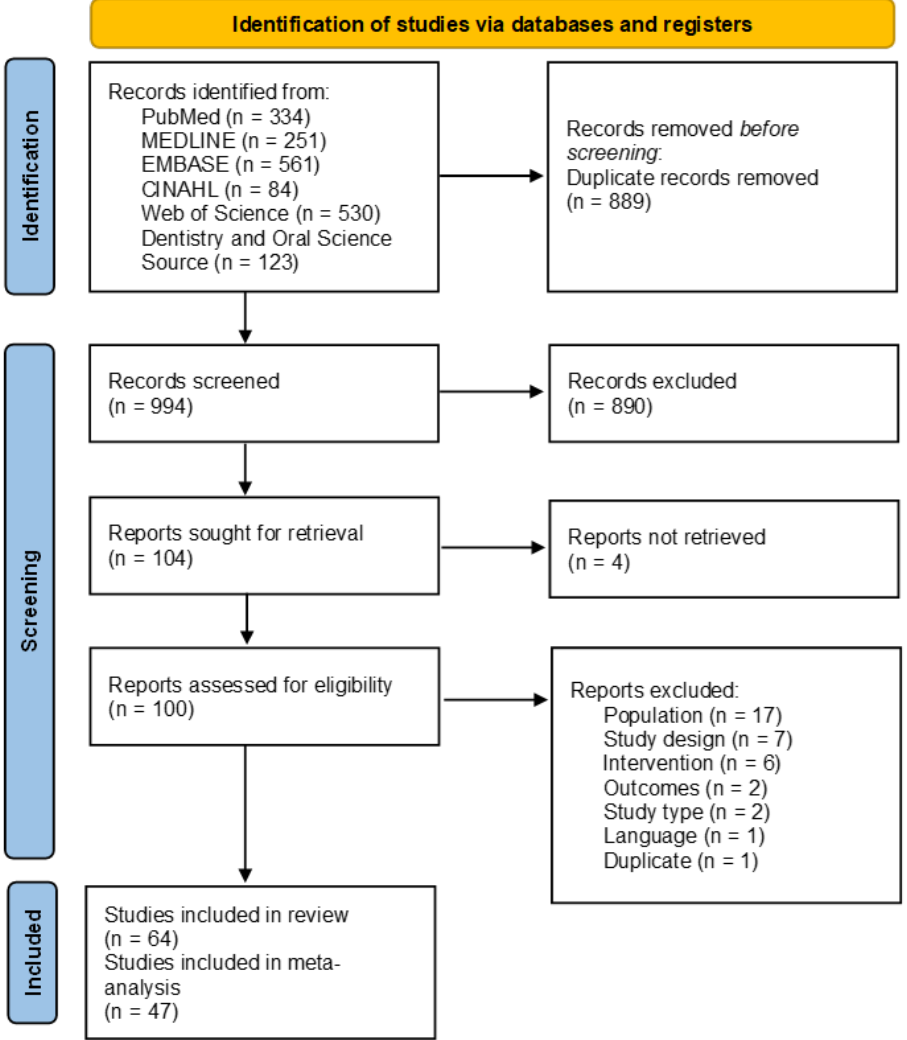
Figure 2. Preferred Reporting Items for Systematic Reviews and Meta-Analyses (PRISMA) flow diagram detailing the study selection.